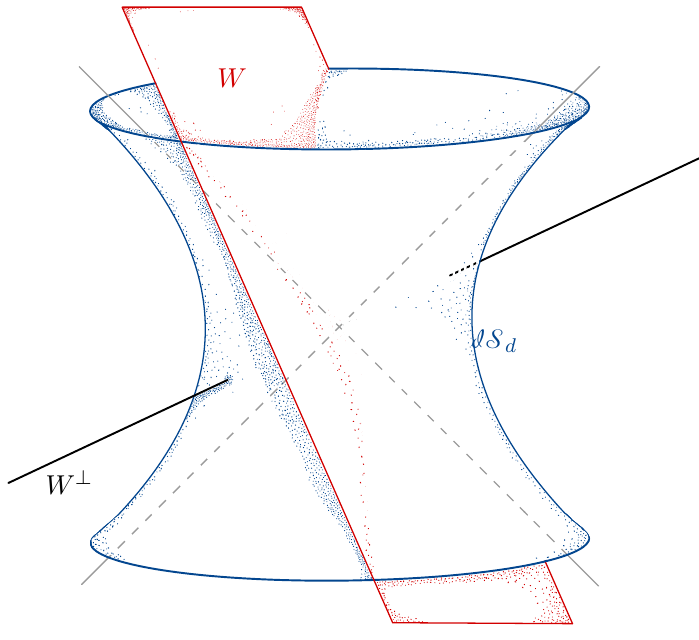
Figure 5 . Spi / Z 2 fibering over elliptic de Sitter